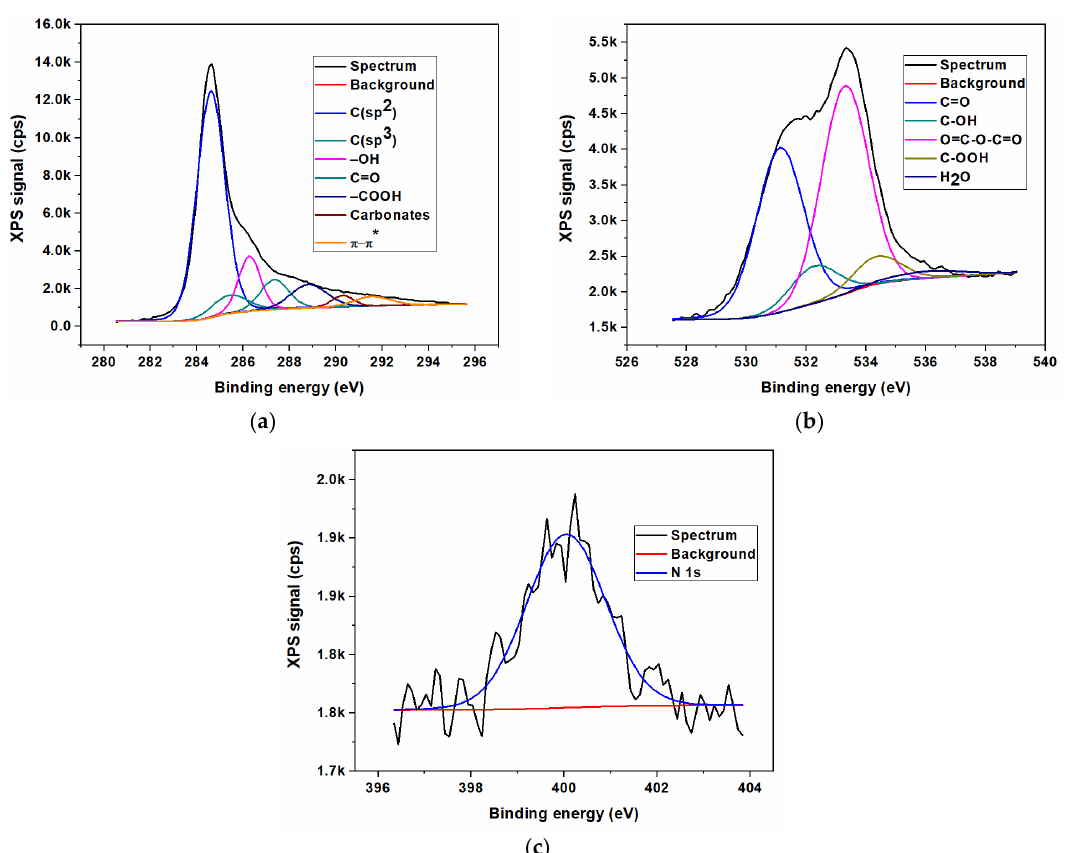
Figure 5. XPS high resolution spectra for nitrogen-doped graphene oxide synthesized using urea